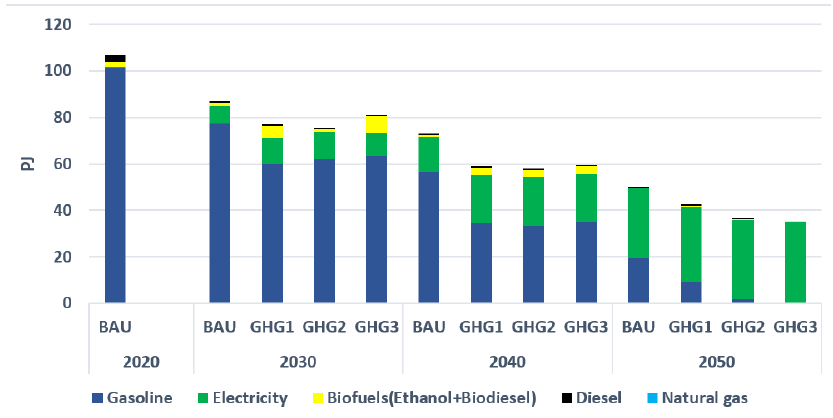
Figure 7. Final energy consumption by type in the transport sector.